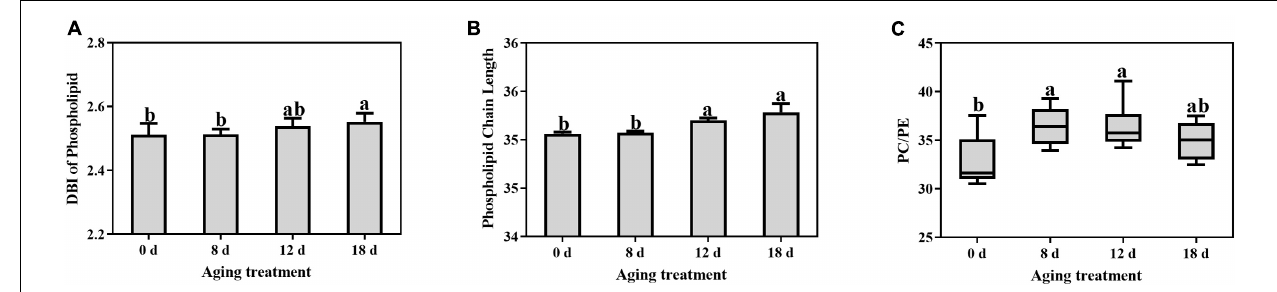
FIGURE 6 | Effects of artificial aging treatment on the phospholipid (A) DBI, (B) ACL, and (C) PC/PE ratio. Data shows the mean ± SD of six biologically independent experiments. Columns marked with different letters (a-b) are statistically significantly different ( p < 0.05).